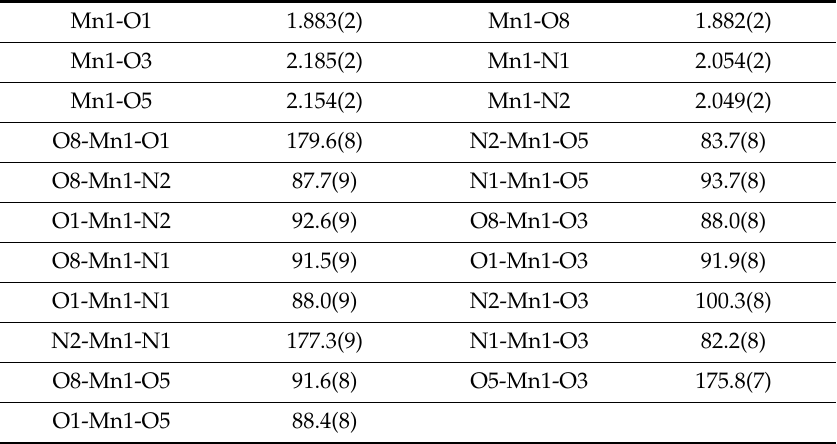
Figure 1. Partially labeled representation of the anion of complex 1 . Color scheme: Mn III , blue; Cl, purple; O, red; N, green; C, gray. H atoms are omitted for clarity. Table 2. Selected interatomic distances (Å) and angles (°) for complex 1 ∙MeOH.